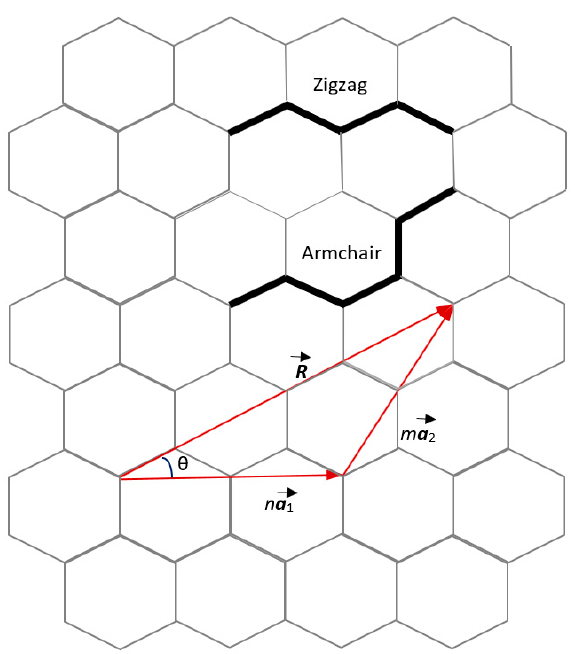
Figure 1. Schematic diagram of the chirality of a graphene hexagonal lattice with lattice vectors a 1 and a 2 .